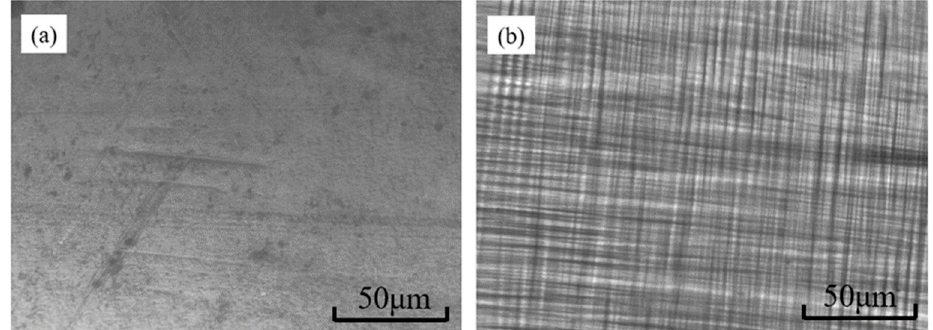
Figure 2. The microscopic images of the sample. ( a ) The reflection microscope image; ( b ) the trans‑ mission microscope image.